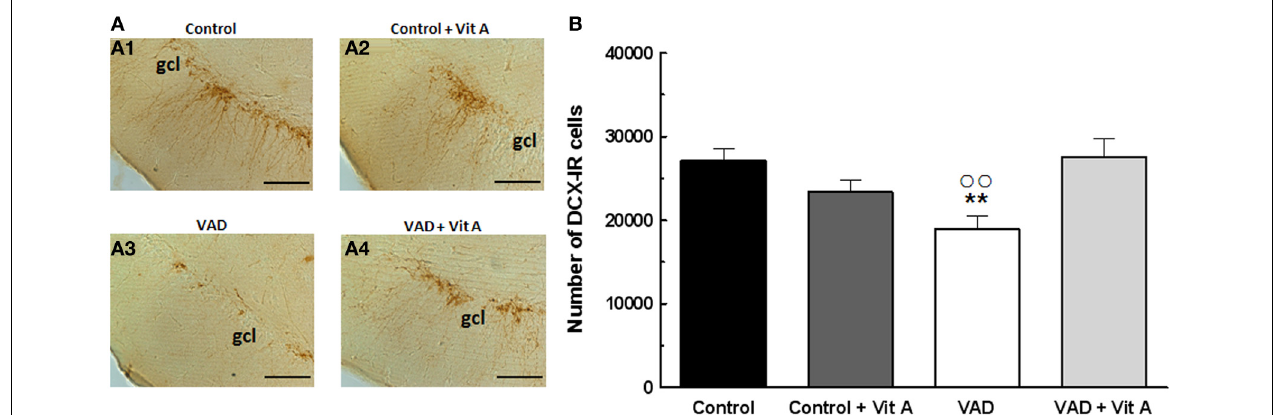
FIGURE 4 | Effects of 14 weeks of VAD and vitamin A supplementation on hippocampal neurogenesis. (A) Images show the immunoperoxydase staining of DCX-IR cells in the DG granule cell layer in the different groups: Control (A1), Control + Vit A (A2), VAD (A3), VAD + Vit A (A4). (B) Number of DCX-IR cells in the DG granule